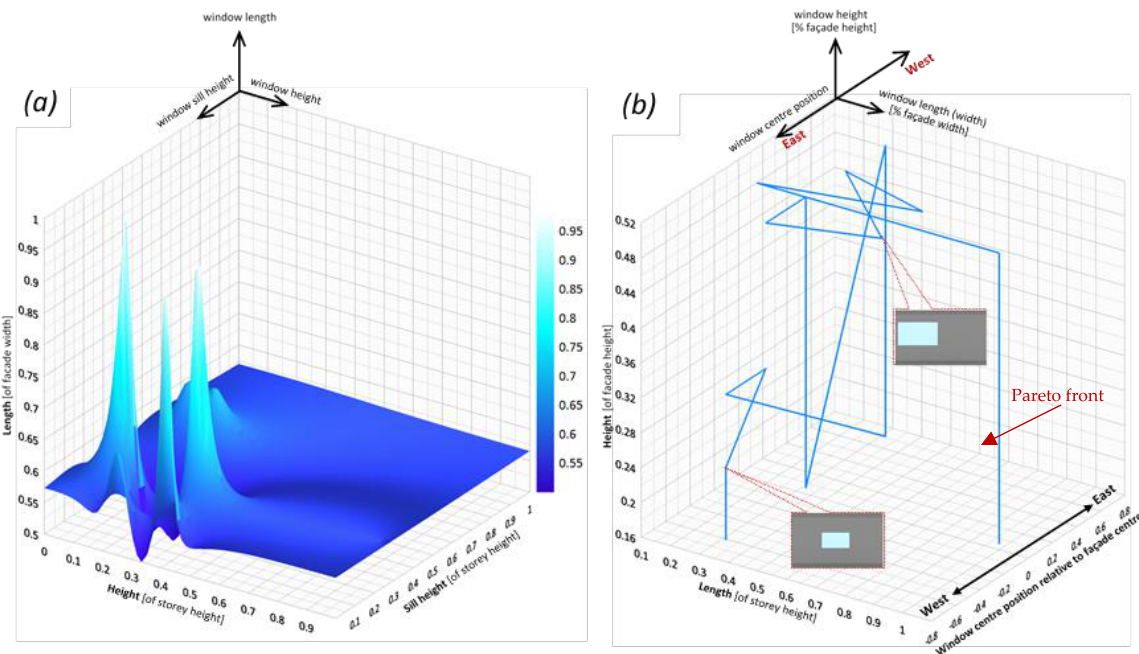
Figure 5. Acceptable range for: ( a ) window dimensions and sill levels; and ( b ) window dimensions and position relative to the